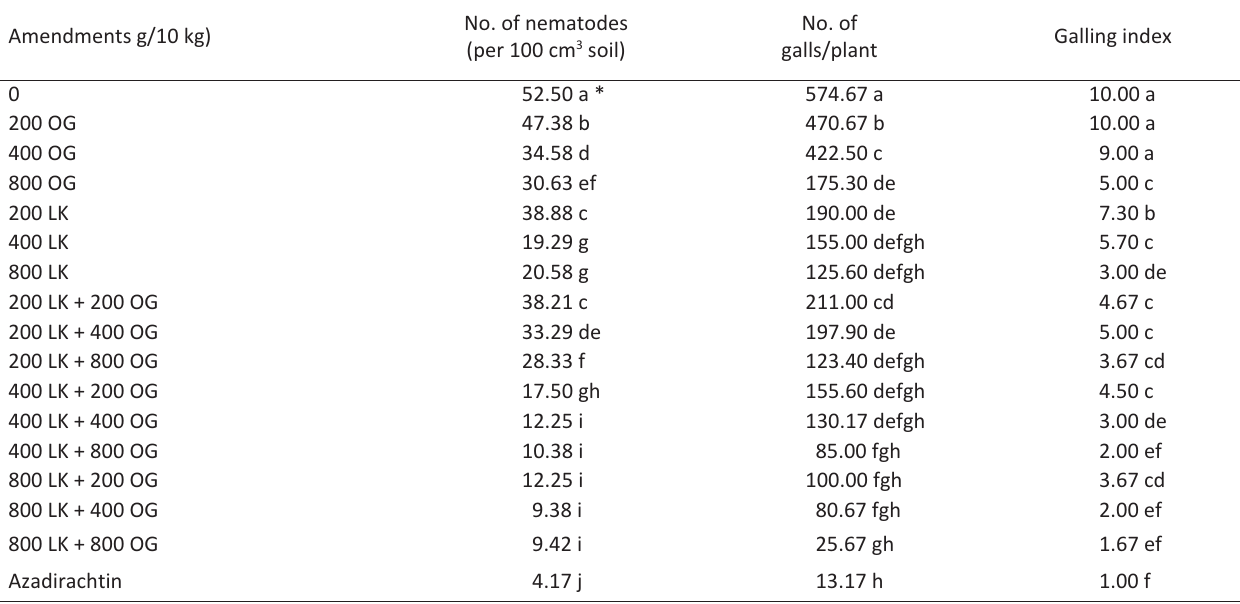
Table 2 ­ Effect of fresh organic amendments on nematode population, gall number and galling index